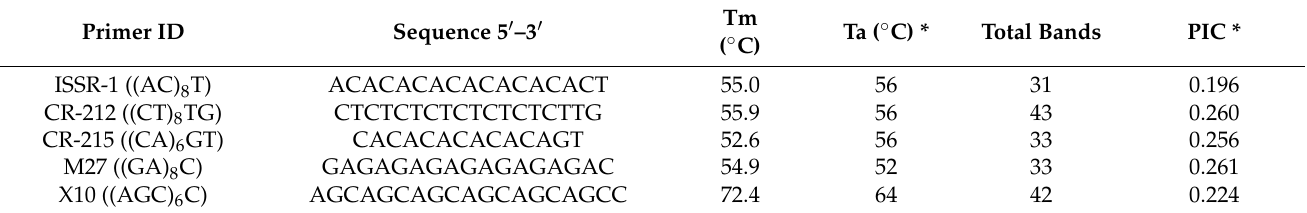
Table 1. The information of ISSR primers is used to assess the genetic diversity of P. sylvestris